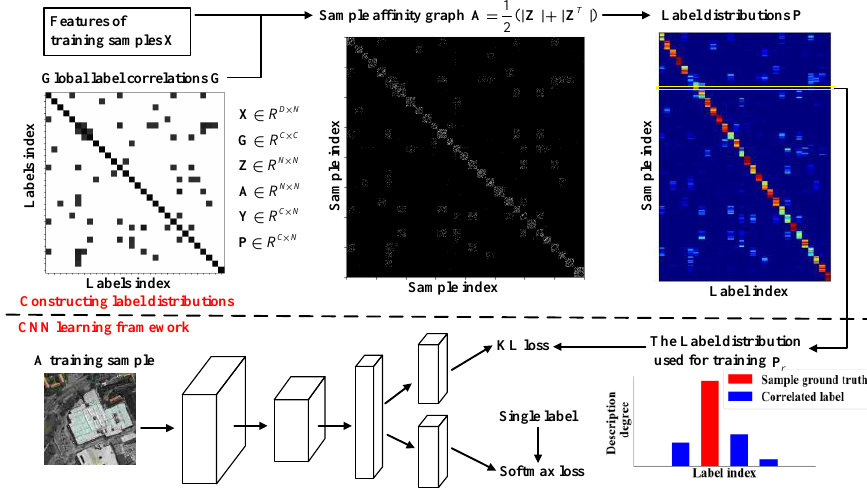
Figure 3. Flowchart of our method.